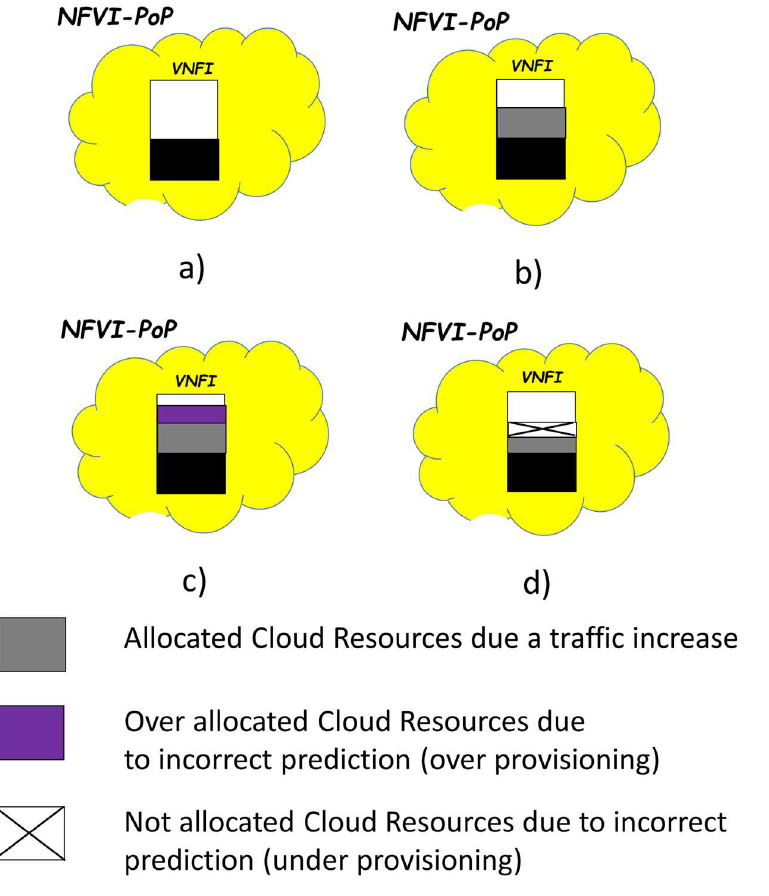
Figure 1. Cloud resource allocation for one Virtual Network Function Instance (VNFI) in a Network Function Virtual Infrastructure-Point of Presence (NFVI-PoP) ( a ); resource reconfiguration when a traffic increase occurs ( b ); resources over ( c ) and under ( d ) provisioning when a traffic prediction error is